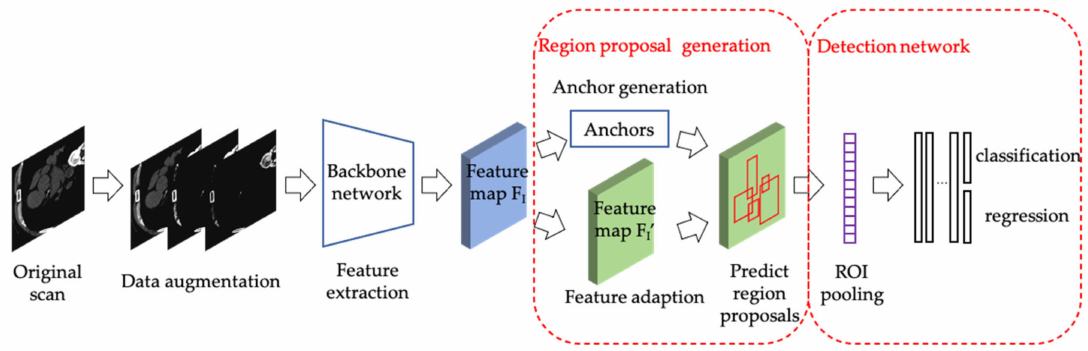
Figure 1. The framework of the proposed automatic